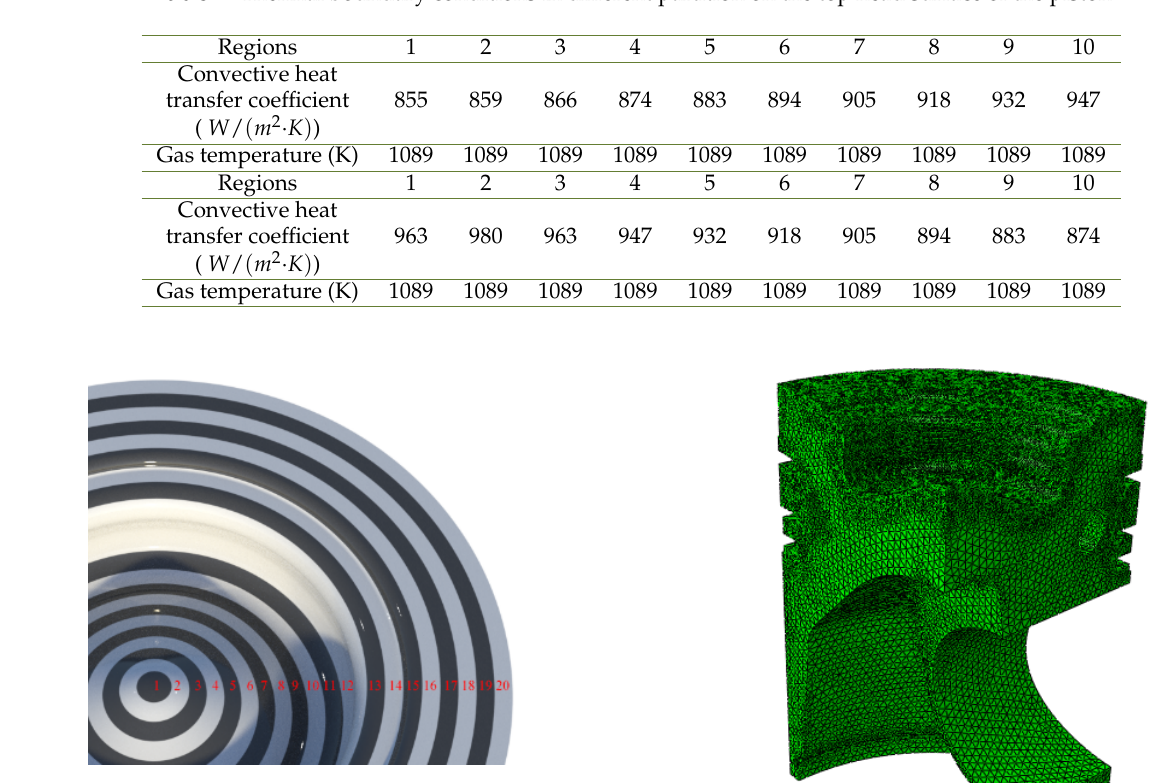
Table 2. Thermal boundary conditions in different partition on the top head surface of the piston